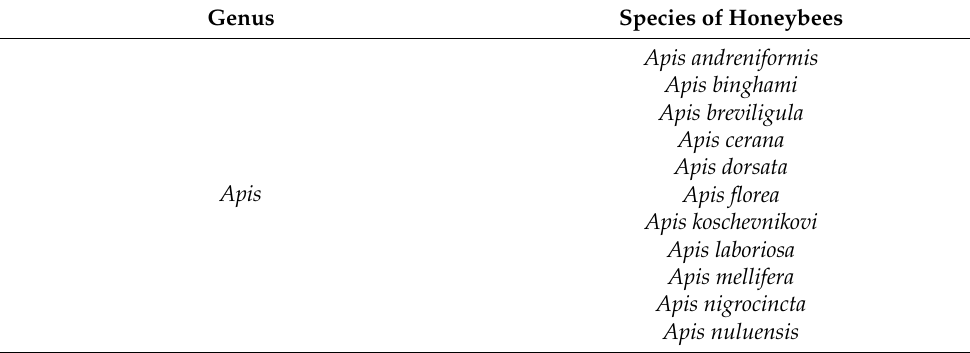
Table 1. Eleven honeybees species as recorded worldwide